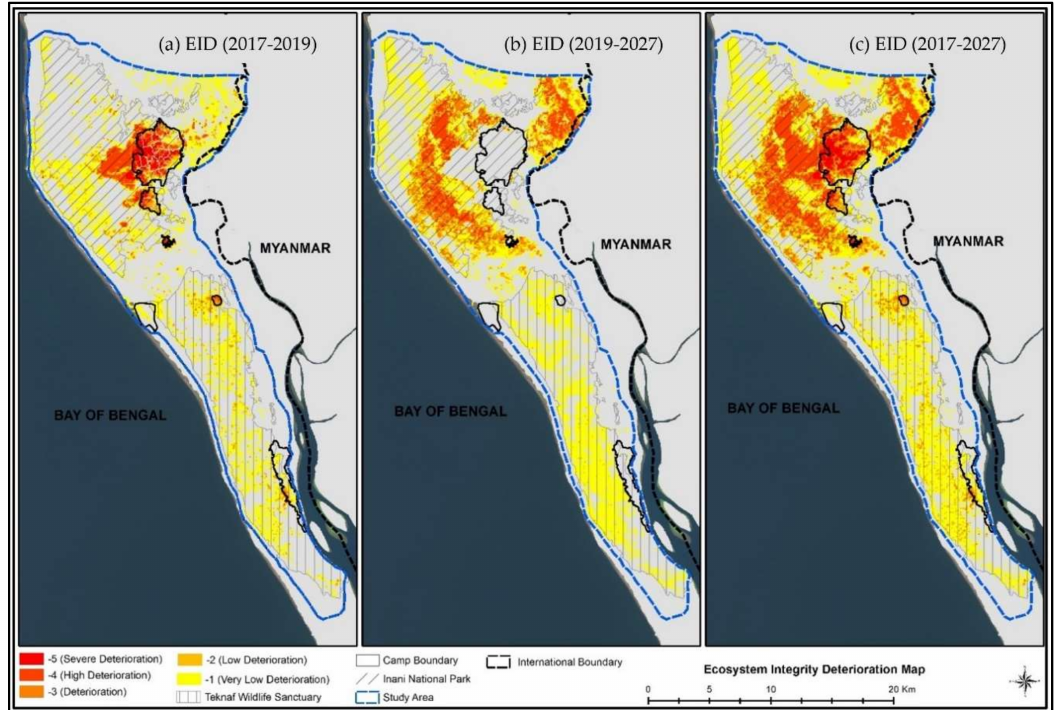
Figure 9. Ecosystem integrity depletion status of the Cox’s Bazar–Teknaf Peninsula for three different temporal